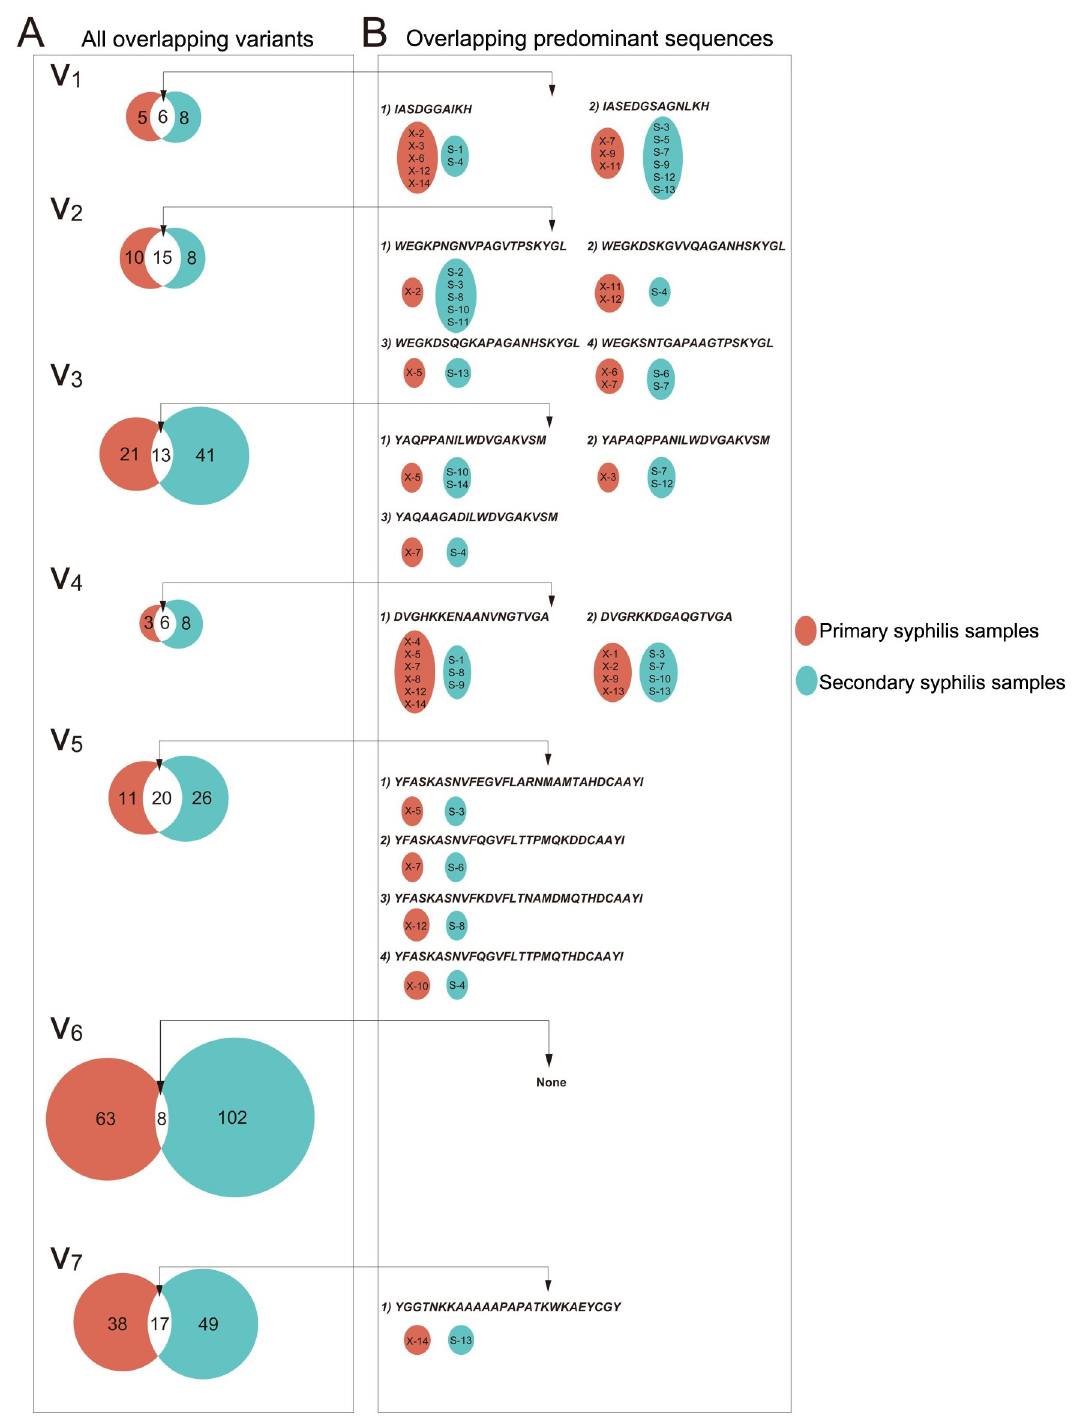
Fig 4. Overlapping amino acid sequences within the V region between the samples at the two different stages. (A) Each Venn diagram presents the overlapping amino acid sequences in the V regions of tprK in primary and secondary syphilis patients. The numbers in the red and green circles represent the total number of amino acid variants that are unique to primary and secondary syphilis patients, respectively. The number in the intersection of the two circles represents the number of overlapping variants. (B) The figure shows the overlapping predominant sequences within the V regions and the redundancy of these sequences in primary and secondary syphilis samples.